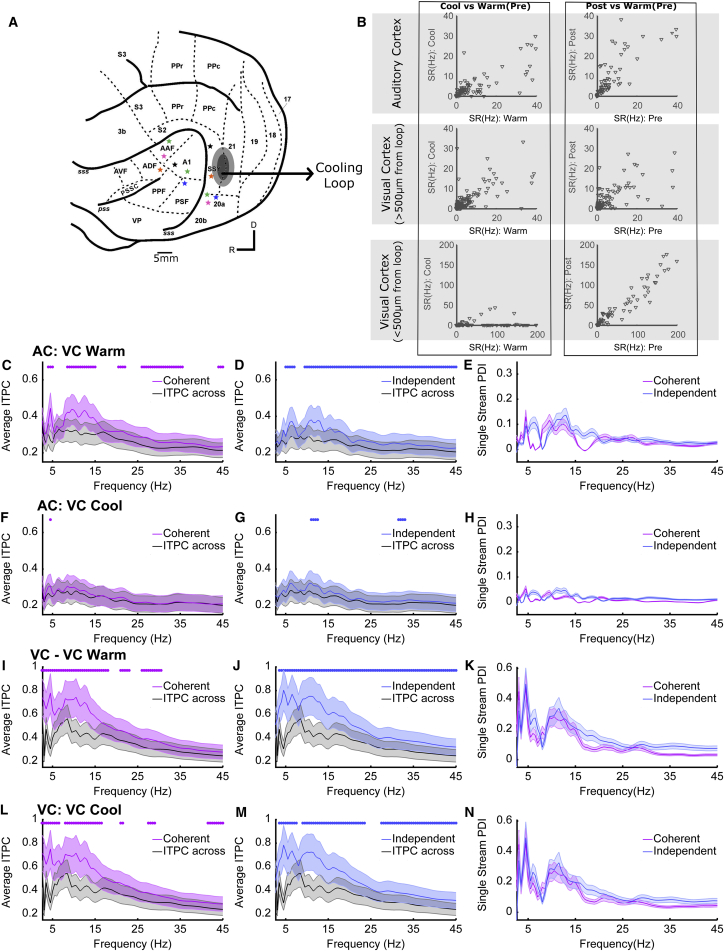
Visual-Stimulus-Induced LFP Phase Changes in Auditory Cortex Are Mediated by Visual Cortex(A) Schematic showing the location of auditory cortical recording sites and the location of a cooling loop (black, gray line marks the 500-μm radius over which cooling is effective; Wood et al., 2017), which was used to inactivate visual cortex. Individual recording sites contributing to (C)–(N) are shown with stars (simultaneous recordings are marked in the same color).(B) Spike rate responses in auditory cortex (top row) and visual cortex (bottom row, sites >500 μm from the loop) in response to noise bursts or light flashes before, during, and after cooling.(C and D) Inter-trial phase coherence values (mean ± SEM) for the coherent (C) and independent (D) auditory-visual stimuli recorded in auditory cortex (AC) prior to cooling visual cortex (VC) compared to the shuffled null distribution (inter-trial phase coherence across). Asterisks indicate the frequencies at which the inter-trial phase coherence values are significantly different from the shuffled inter-trial phase coherence-across distribution.(E) Single-stream phase dissimilarity index values calculated from the inter-trial phase coherence values in (C) and (D).(F–H) As in (C)–(E) but while visual cortex was cooled to 9 degrees.(I–N) As in (C)–(H) but for sites in visual cortex >500 μm from the cooling loop. (C)–(H) include data from 83 sites from 6 electrode penetrations; (I)–(N) include data from 47 sites from five penetrations.